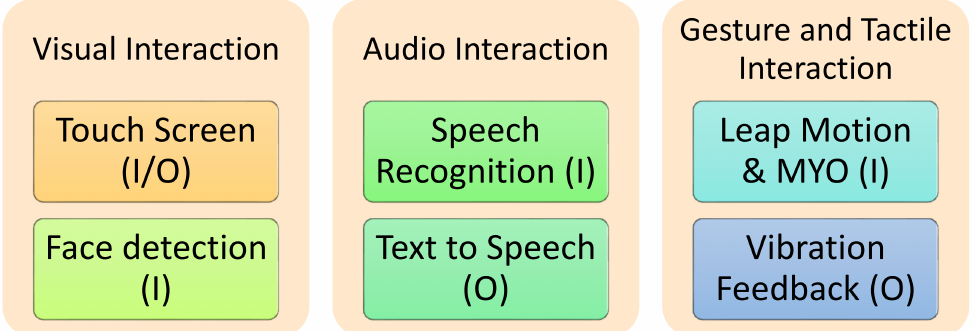
Figure 7. Multimodal natural interaction of the Smart Driving Interface (I is for input; O is for